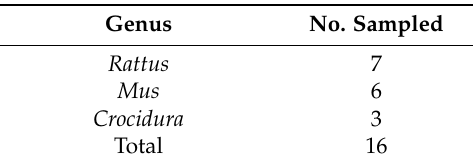
Table 2. Rodents captured in houses in Lifomi and Boende, the Democratic Republic of the Congo 2013. These animals are also included in data from Table 1.